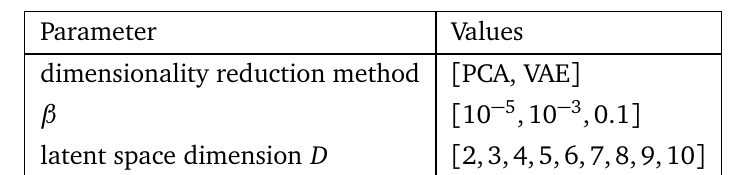
Table 14: KDE model